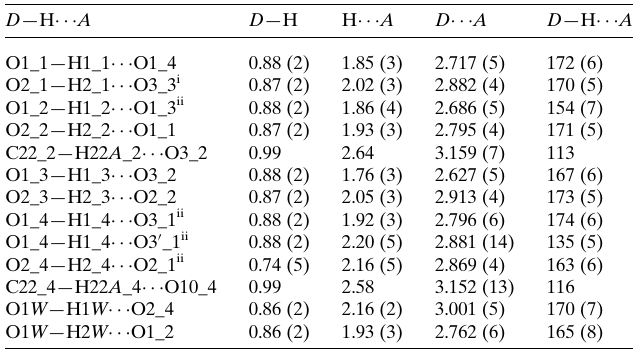
Table 1 Hydrogen-bond geometry (A˚ , (cid:5) ).